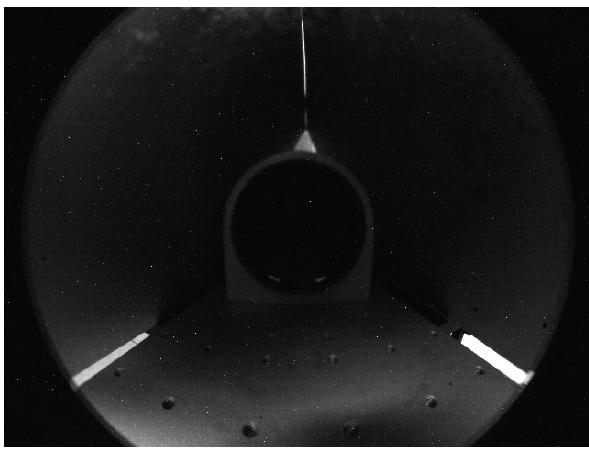
Figure 7. Example of frame captured by the camera for the estimation of the mirror position in the image